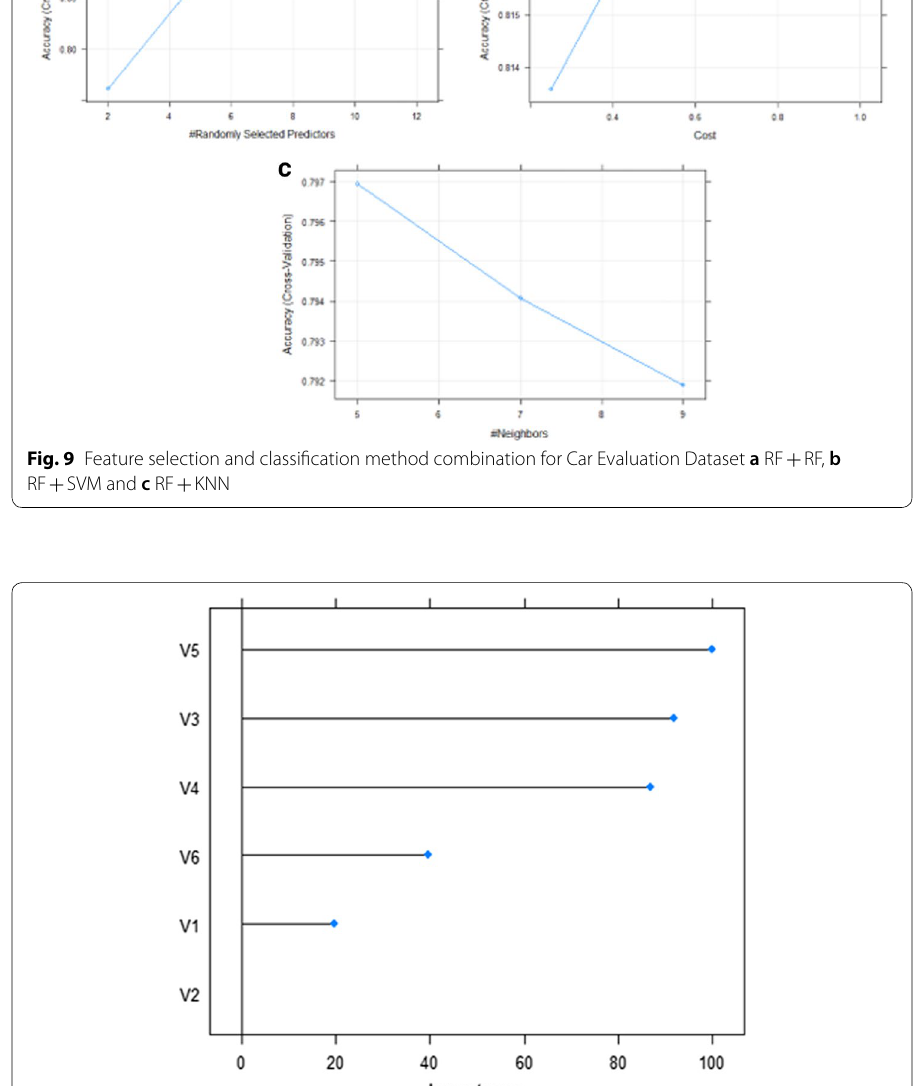
Fig. 10 The important measure for each variable of Human Activity Recognition Using Smartphones Dataset using Random